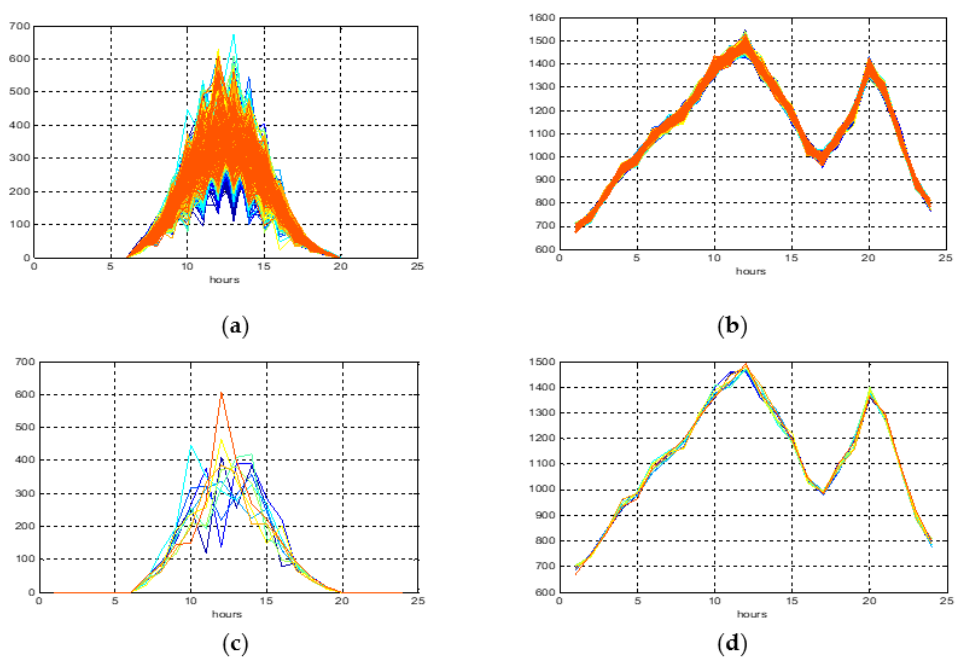
Figure 3. Clustered ( a ) PV output scenarios and ( b ) load profile scenarios; reduced ( c ) PV output scenarios and ( d ) load profile